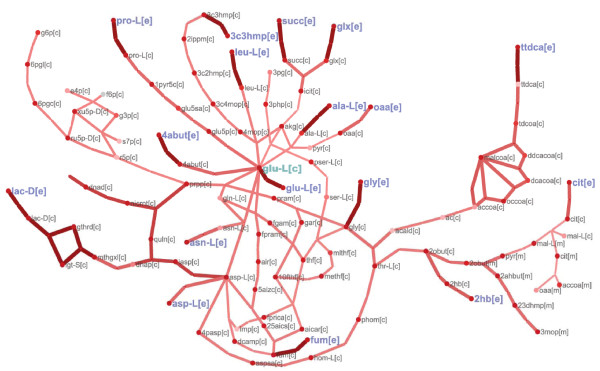
Perturbation reaction subnetwork of gdh1/GDH2 mutant under anaerobic conditions. Subnetwork illustrates the highly perturbed anaerobic reactions of similar Zreaction magnitude to the reactions in Figure 3. A significantly larger number of reactions indicates mutant metabolic effects are more widespread in the anaerobic environment. The network shows that perturbed pathways converge on glutamate, the main site in which the gdh1/GDH2 modification was introduced, which suggests that the direct genetic perturbation effects are amplified under this environment. Metabolite abbreviations are found in Additional file 1.